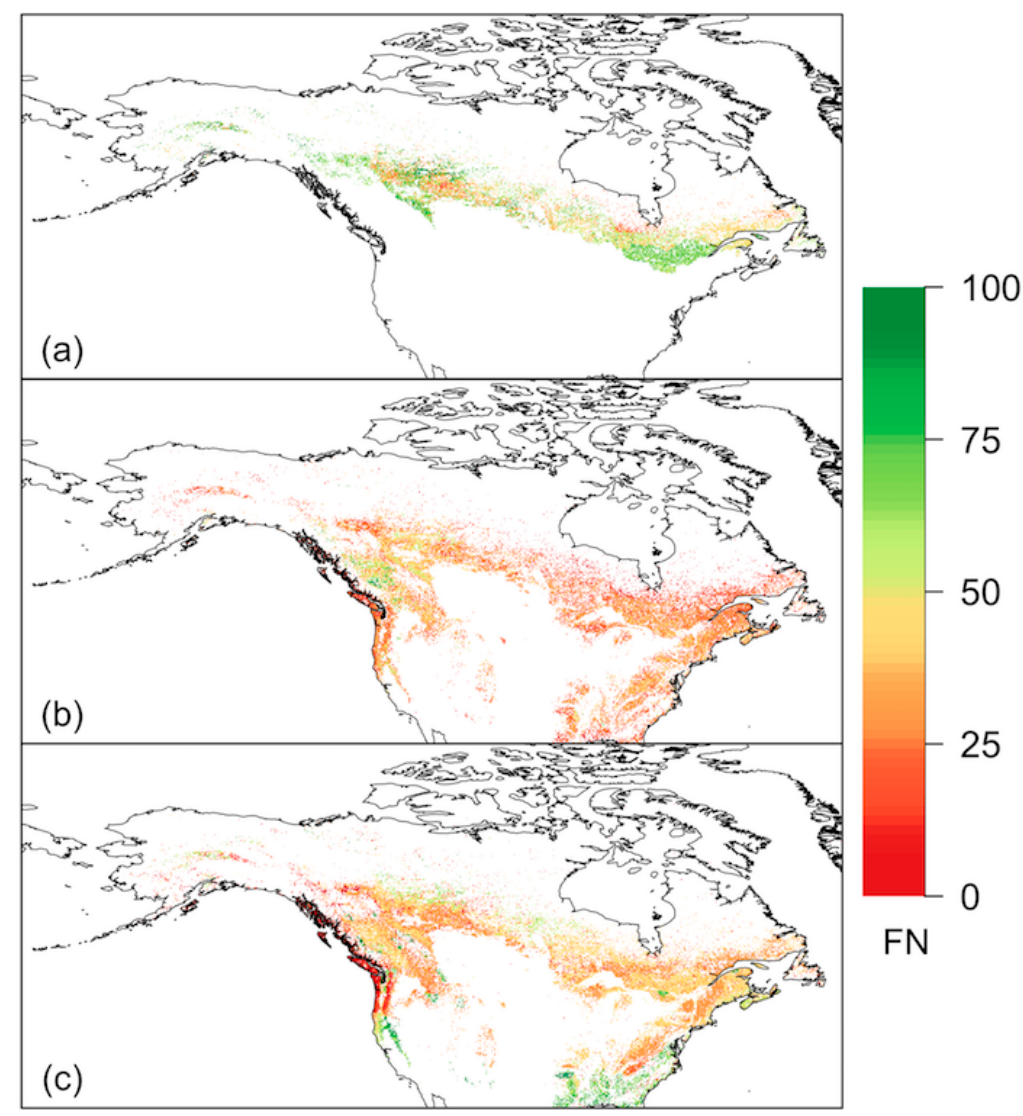
Figure 10. The spatial similarity map between our global wall-to-wall forest AGB product and the products from ( a ) Margolis et al. (2015) [74]; ( b ) Thurner et al. (2014) [54]; and ( c ) Reusch & Gibbs (2008) [73] in the North America boreal forest area.